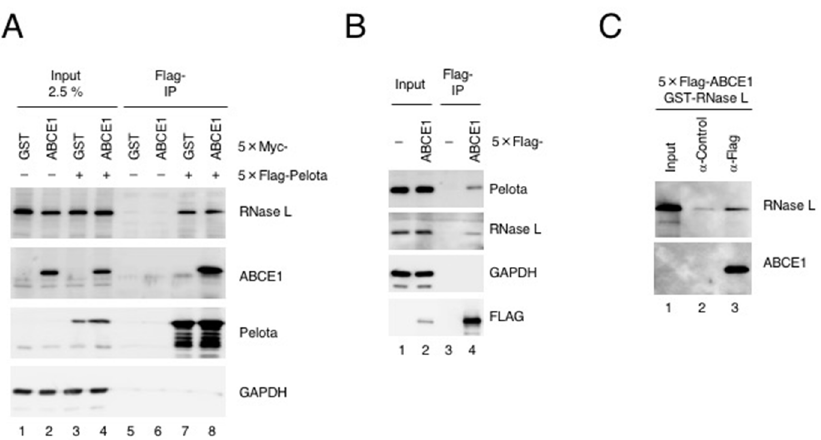
Figure 1. ABCE1 directly binds RNase L. ( A ) HeLa cells expressing 5 × Myc-GST or 5 × Myc-ABCE1 in combination with 5 × Flag-Pelota were lysed in bu ff er B and the lysates were subjected to immunoprecipitation with anti-Flag-M2 agarose. Proteins coprecipitated with 5 × Flag-Pelota were analyzed by western blotting with the indicated antibodies ( n = 2). ( B ) HeLa cells expressing 5 × Flag-ABCE1 were lysed in bu ff er B and the lysates were subjected to immunoprecipitation with anti-Flag-M2 agarose. Endogenous proteins coprecipitated with 5 × Flag-ABCE1 were analyzed by western blotting with the indicated antibodies ( n = 2). ( C ) Purified 5 × Flag-ABCE1 and recombinant GST-RNase L were incubated with Protein G Sepharose 4 Fast Flow mixed in advance with either anti-Flag antibody or mouse IgG (control) in bu ff er B at 10 ◦ C for 1 h. GST-RNase L coprecipitated with 5 × Flag-ABCE1 was analyzed by western blotting with the indicated antibodies ( n =